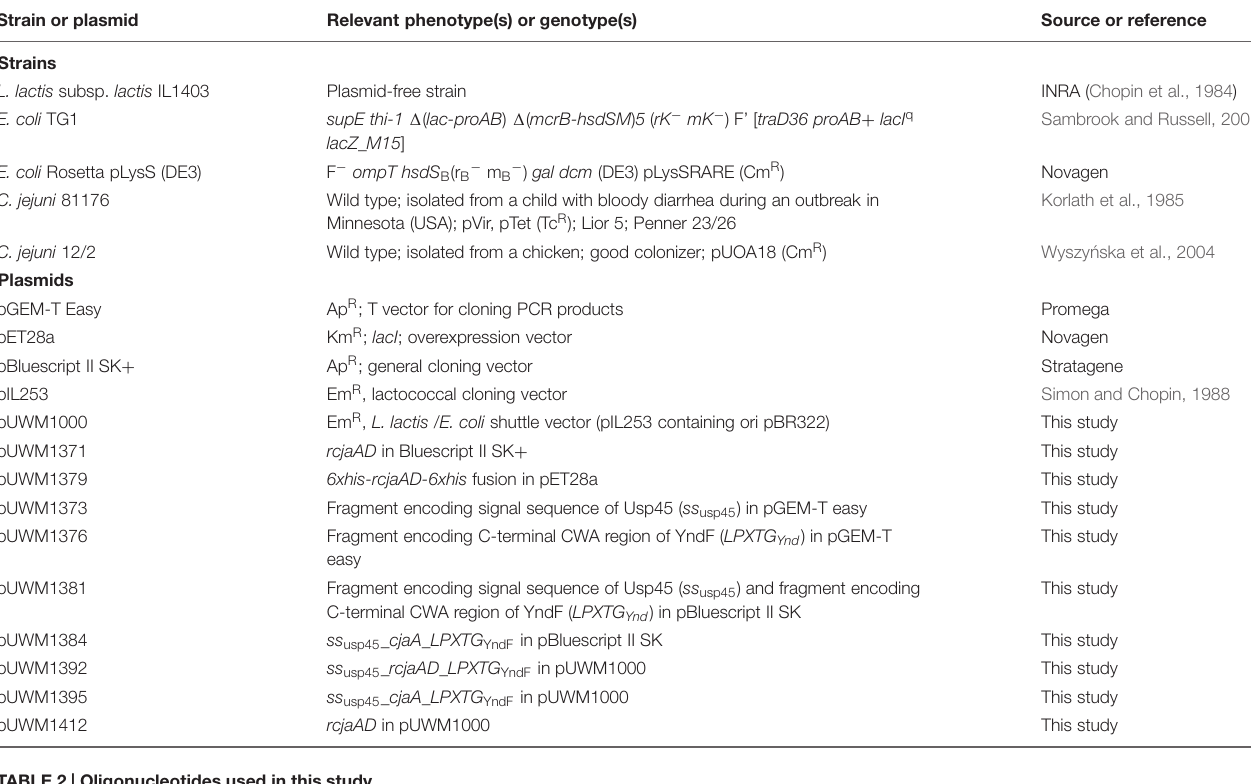
TABLE 1 | Bacterial strains and plasmids used in this study.